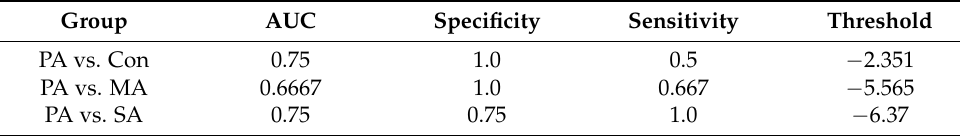
Table 3. Performance of four-lncRNA panel as biomarkers for peanut allergy. Group